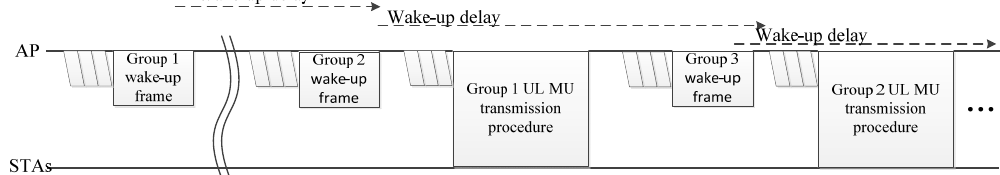
Figure 10. Scheduled uplink multiuser transmission using wake-up packet for multiple user. UL MU = uplink multi-user.